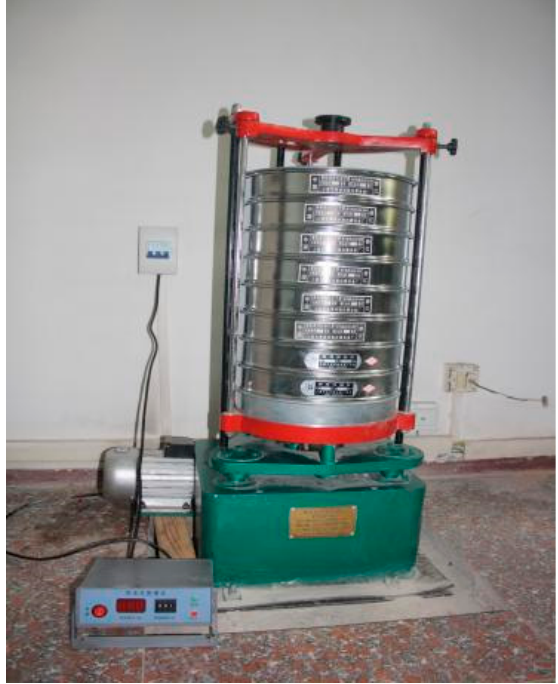
Figure 4. Standard Vibration Pendulum Instrument.